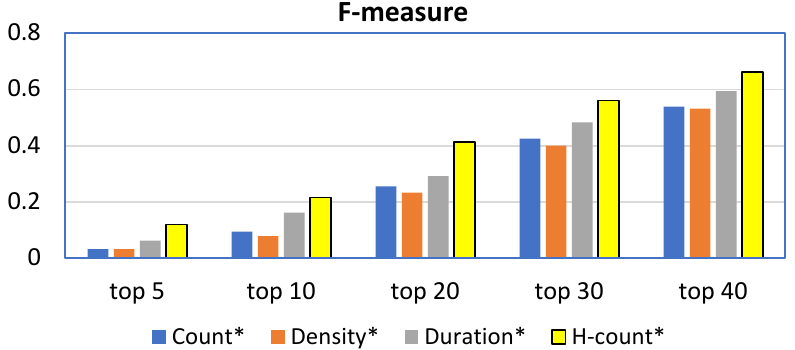
Figure 8. F-measure comparison between H-Count* and three filter-based baselines.